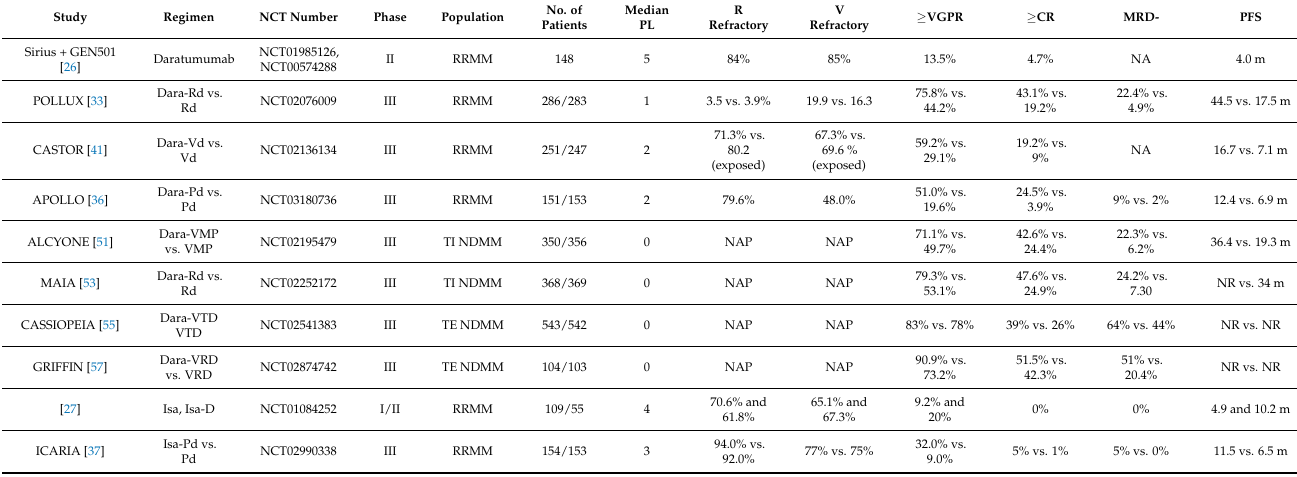
Table 3. Results of the important trials with regimens containing